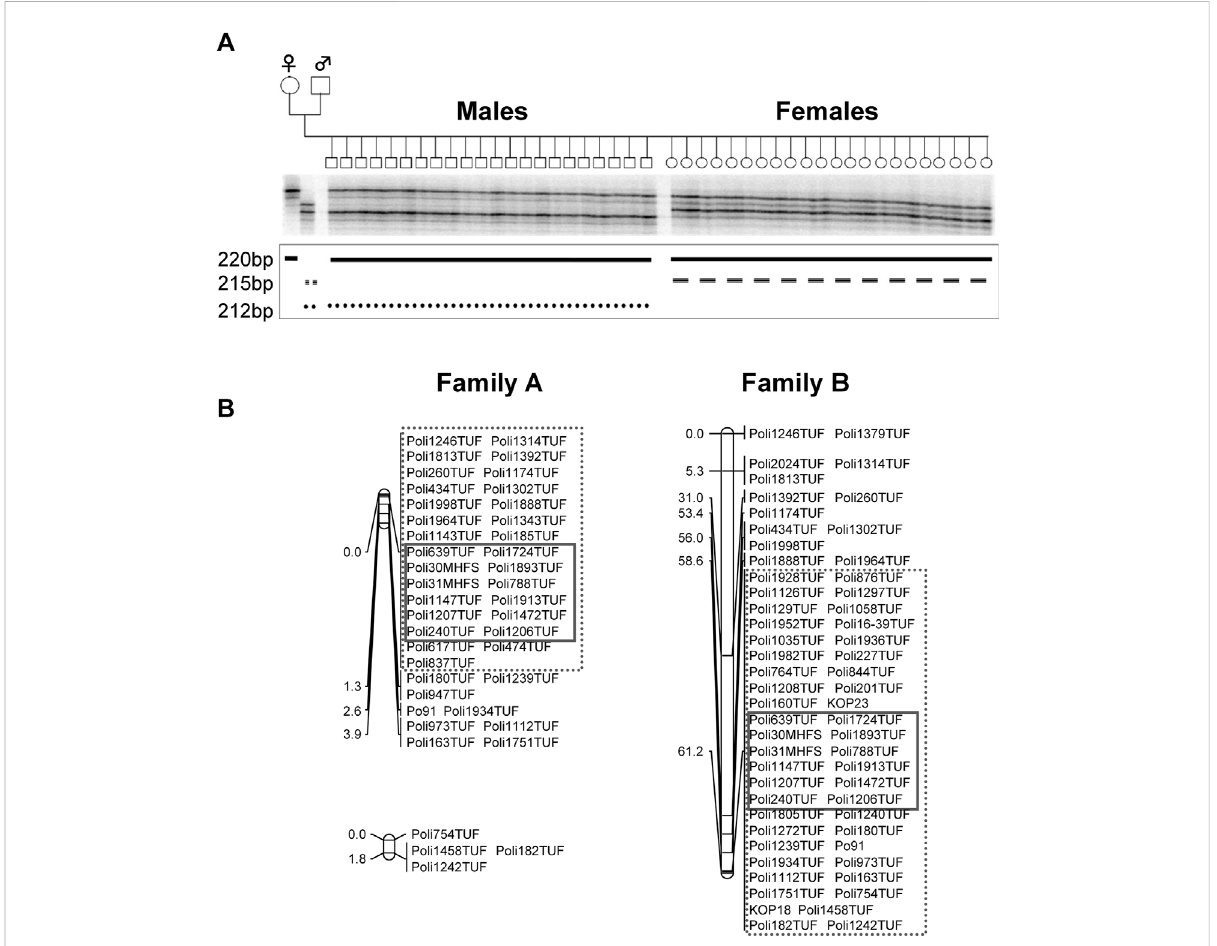
FIGURE 1 AutoradiographofPoli185TUFinJF9intheA-familyatstep1 (A) .Thelower212bpallelefromthemaleparentwastheuniquealleleinheritedby the males of this family. JF9-male linkage map in Family A and JF9 linkage map in Family B (B) Map distances between markers are shown in centimorgans (cM). 35 markers in the enclosure with a dotted line were mapped close to sex-determining locus in A-family, while 46 markers in the enclosure with a dotted line were mapped in family (B) . Common 12 markers in the enclosure with a straight line were detected as closed markers to the sex-determining